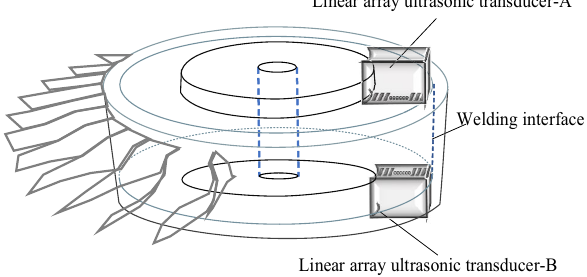
Figure 4. Schematic diagram of bilinear array transducer detecting diffusion weld of superalloy turbine disk.